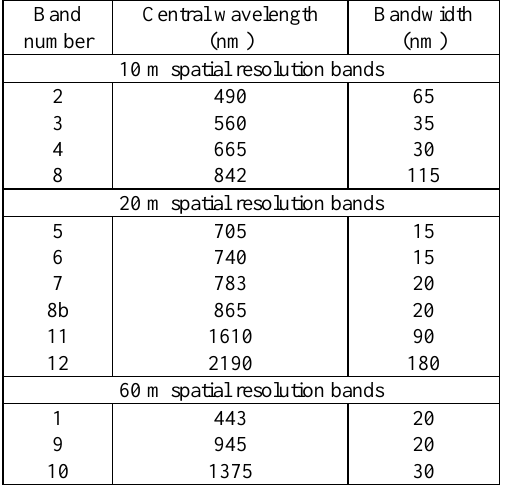
Table 1. Band parameters of Sentinel-2 MSI